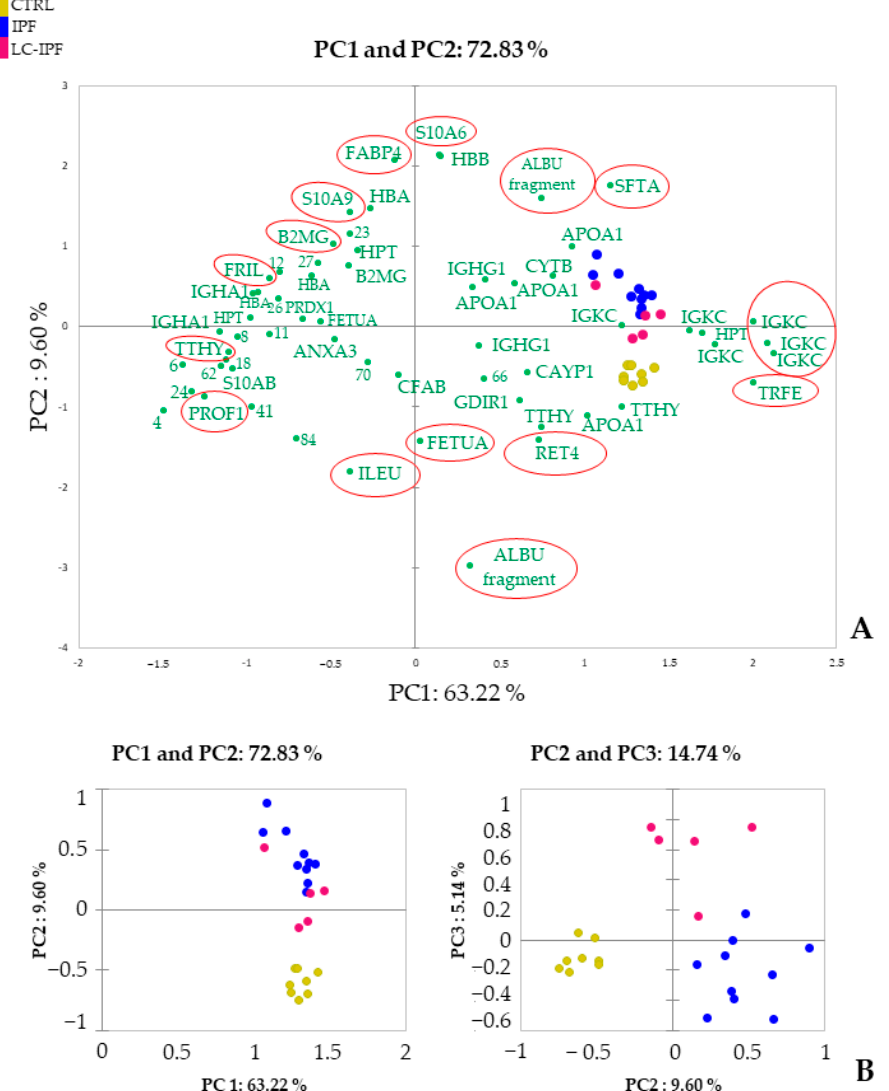
Figure 3. Supervised PCA analysis performed using the DASs detected by proteomic analysis of BALF samples. ( A ). The image reports the contributions of each significant variant in the first two principal components (PC1 and PC2). Red circles mark the most influential spots on the samples distributions. ( B ). Plots highlight the spatial distribution of the analyzed samples along the PC1 and PC2, and PC1 and PC3 (B), and PC2 and PC3 (C).